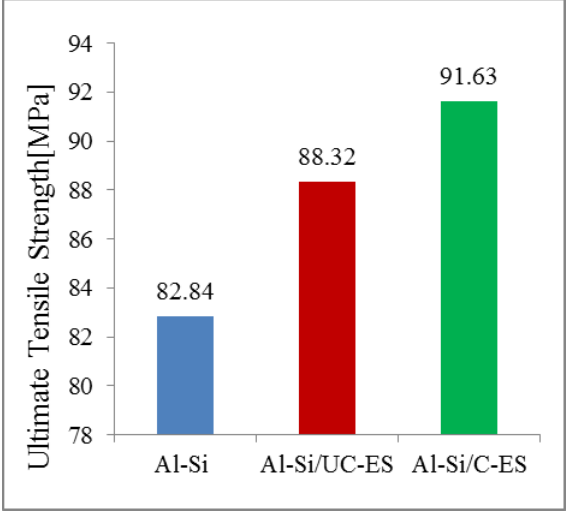
Fig. 8. Comparison of ultimate tensile strength of control sample and the two